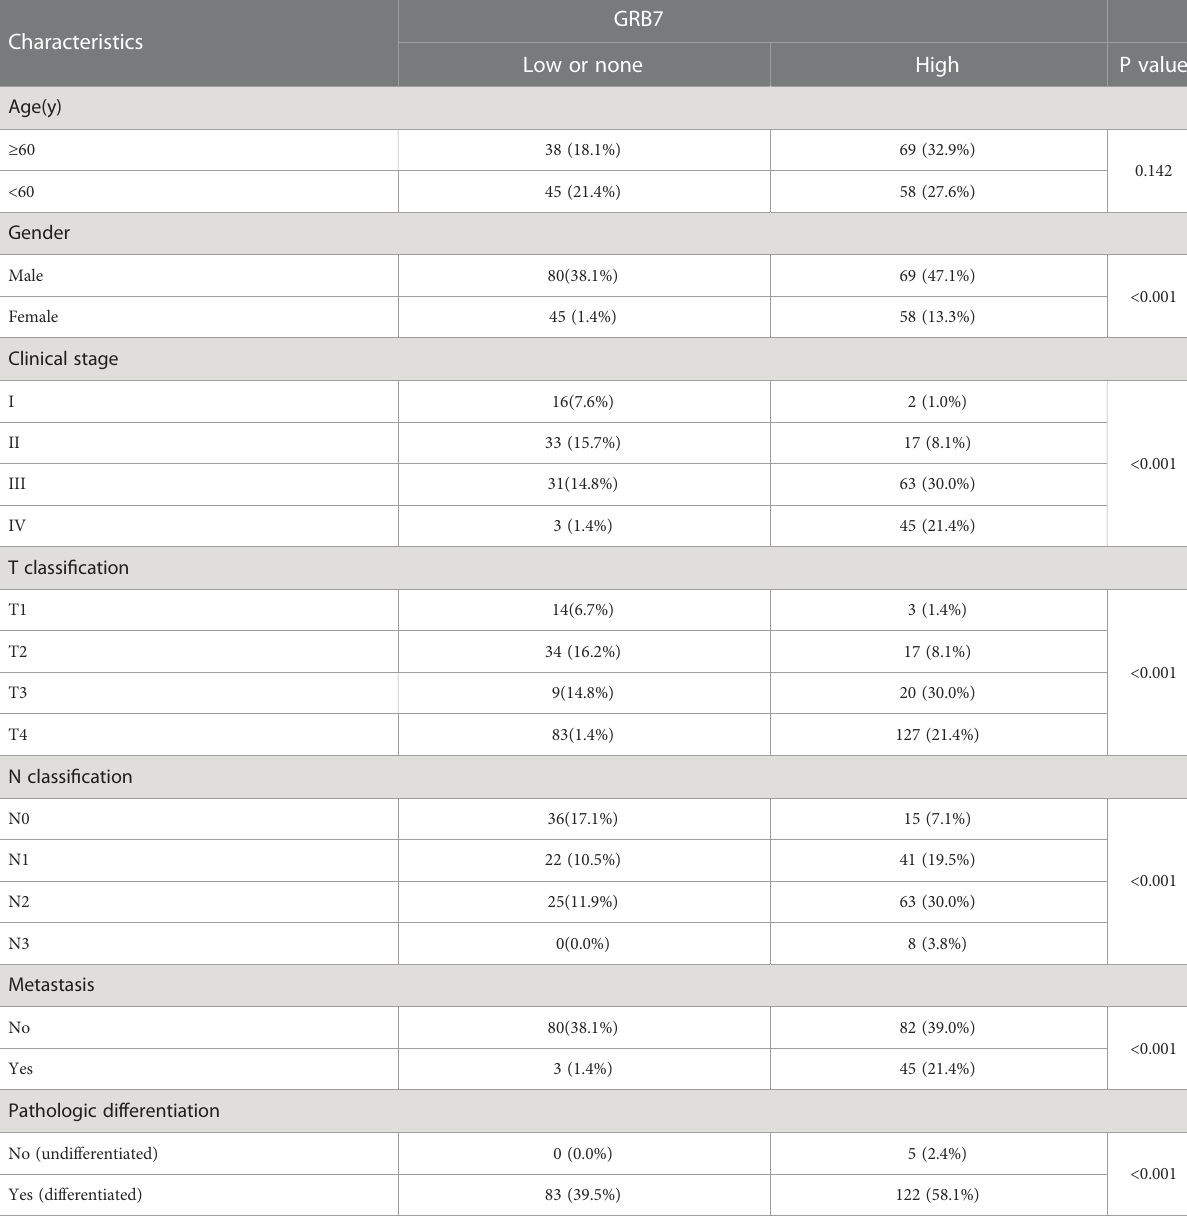
TABLE 1 Correlation between GRB7 expression and clinicopathologic characteristics of gastric cancer patients.